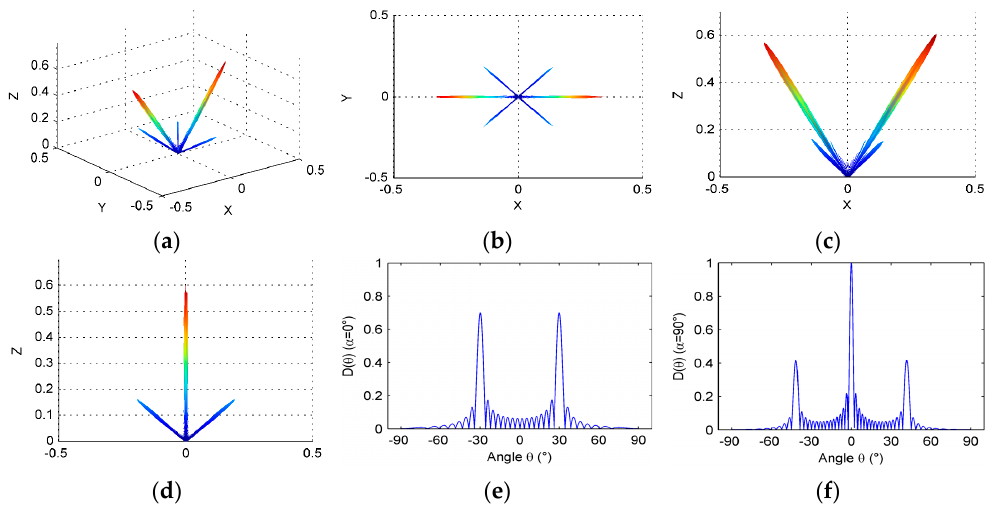
Figure 13. Directivity of linear phased array after optimizing parameters in the lateral direction of the array: ( a ) three-dimensional directivity; ( b ) directivity pattern in x - y plane; ( c ) directivity pattern in x - z plane; ( d ) directivity pattern in y - z plane; ( e ) directivity pattern when α “ α 0 “ 0 ˝ ; and ( f ) directivity pattern when α “ α 0 “ 90 ˝